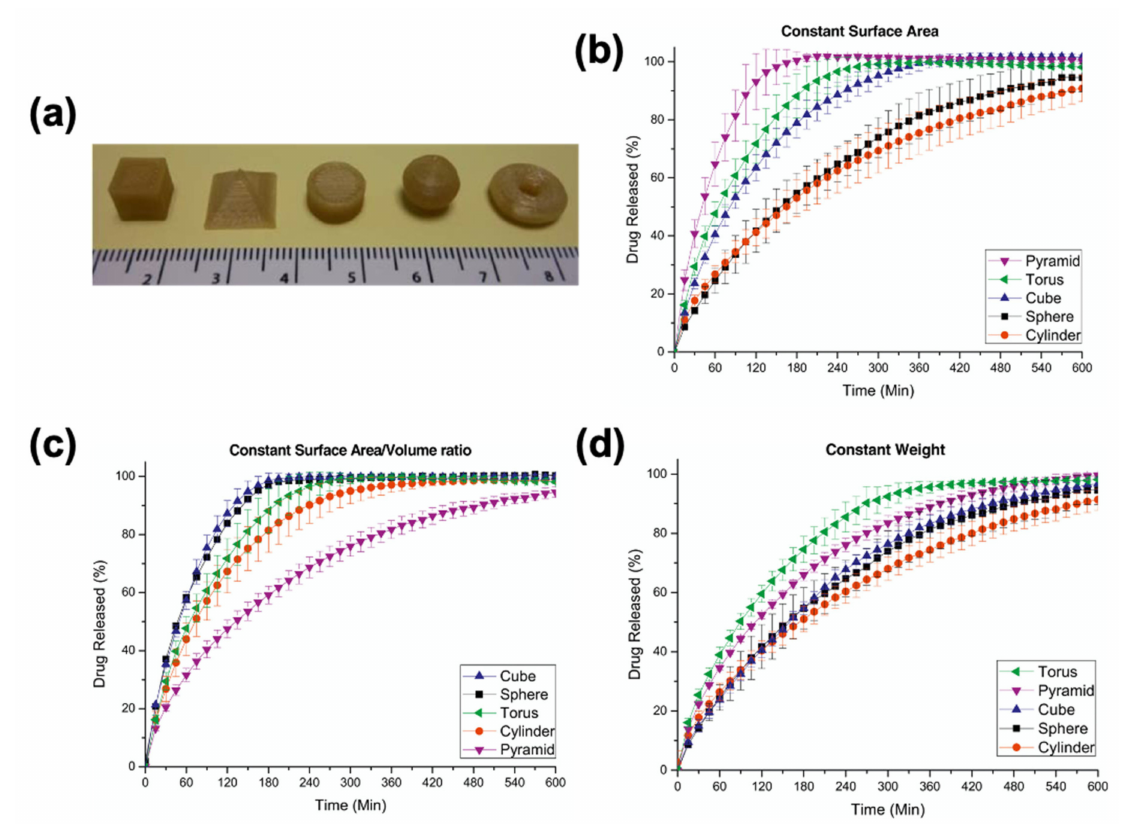
Figure 3. ( a ) FDM-printed paracetamol tablets with different geometries; paracetamol release profile from tablets in phosphate buffer (pH 6.8) with ( b ) 275 mm 2 surface area; ( c ) surface area to volume ratio of 1; ( d ) 500 mg mass. Adapted with permission from Reference [46]. Copyright 2015,